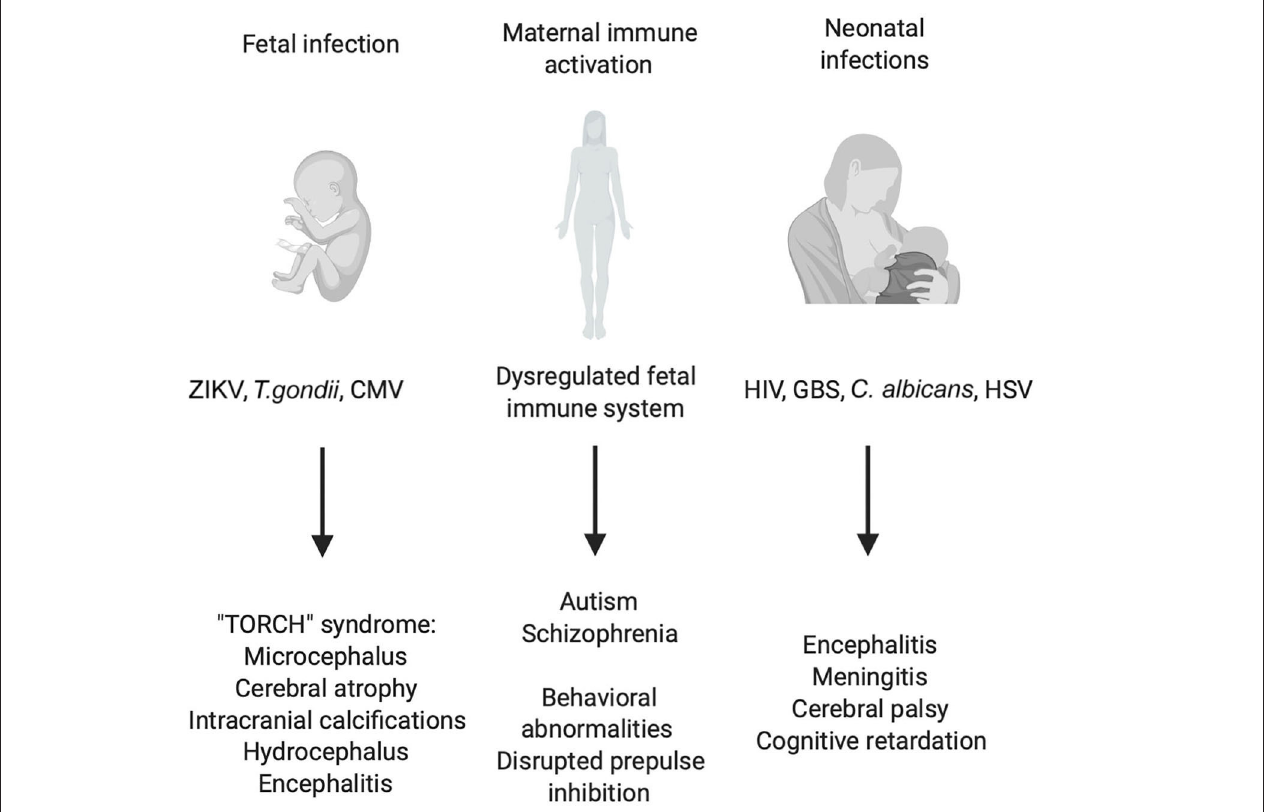
FIGURE 1 | Consequences of early CNS infections and peripheral immune activation for CNS development. Illustration of prenatal and postnatal infections and indirect effects of maternal immune activation (MIA) on the fetus. Different viral, bacterial and parasitic infections can endanger the correct development of the CNS of the fetus leading to a plethora of symptoms grouped under the name “TORCH” syndrome. Also, maternal infection without the transmission of the pathogen to the fetus can have detrimental effects on CNS development which have robustly been linked to schizophrenia and autism spectrum disorder (ASD). Birth and the accompanying contact to environmental pathogens pose a great threat to the unchallenged immune system of the newborn in the worst cases leading to bacterial sepsis, viral encephalitis, and systemic candidiasis.